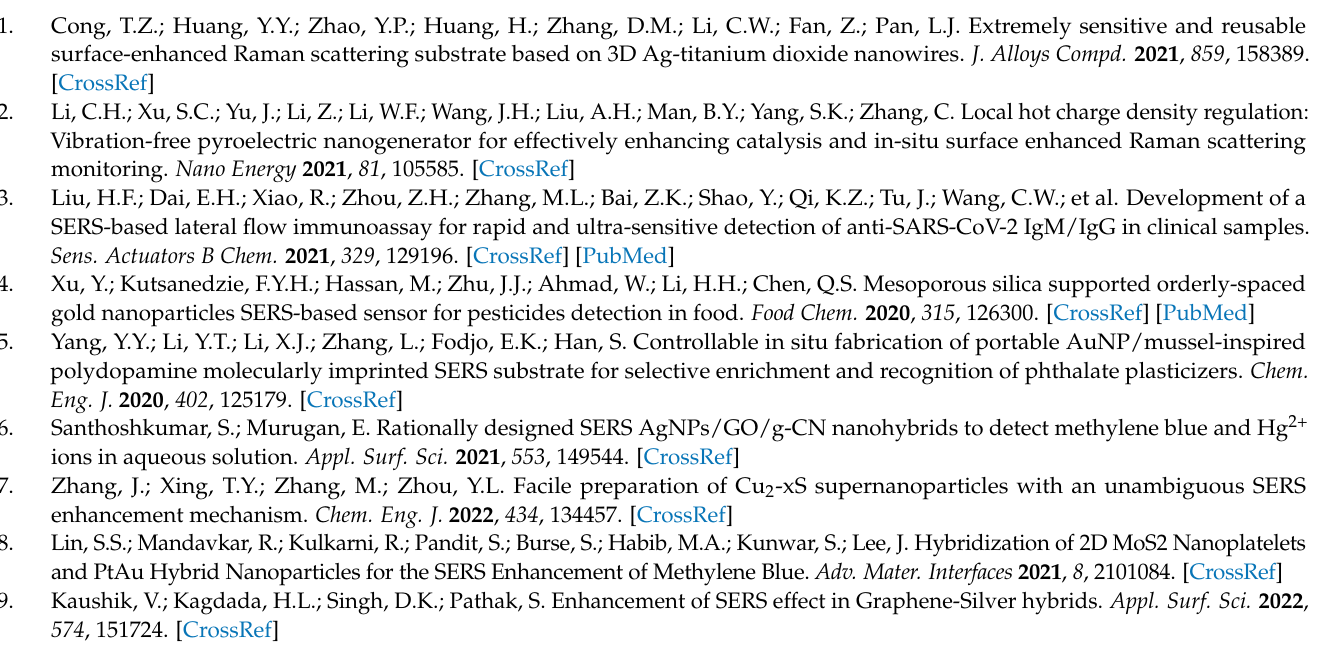
Figure S3: The SERS sensitivities of Ag/TiO 2 -UV with different synthesis time; Figure S4: Raman spectra of MB molecules with different concentrations from 10 − 7 to 10 − 11 M; Figure S5: The self- cleaning ability of Ag/b-TiO 2 susbtrate; Figure S6: The ρ CT value of the Ag/b-TiO 2 -UV-Vis with different irradiation time; Table S1: The comparison of Ag-based SERS substrates simulated by